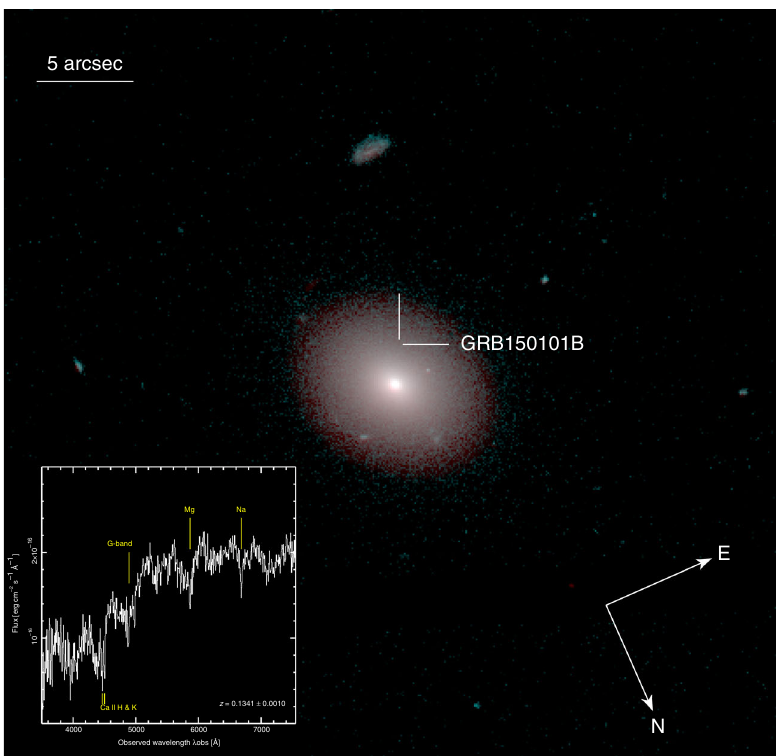
Fig. 5 The host galaxy of GRB150101B. Color image of the host galaxy of GRB150101B created from the HST/WFC3 observations in fi lters F606W (blue, green) and F160W (red). The two intersecting lines mark the location of the GRB afterglow. The galaxy optical spectrum (inset) displays several absorption lines (Ca II H & K, G-band, Mg, and Na at z = 0.1341) and a red continuum